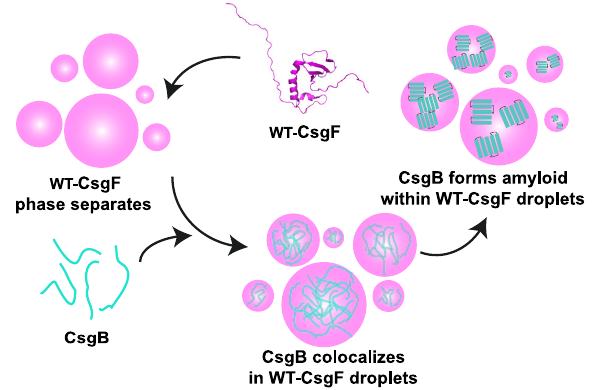
Fig. 7 | Model to show CsgB amyloid formation in the CsgF droplets. WT-CsgF (PDB ID: 5M1U) forms biomolecular condensates. SDS-soluble monomeric CsgB is recruited in the WT-CsgF droplets and undergoes amyloid